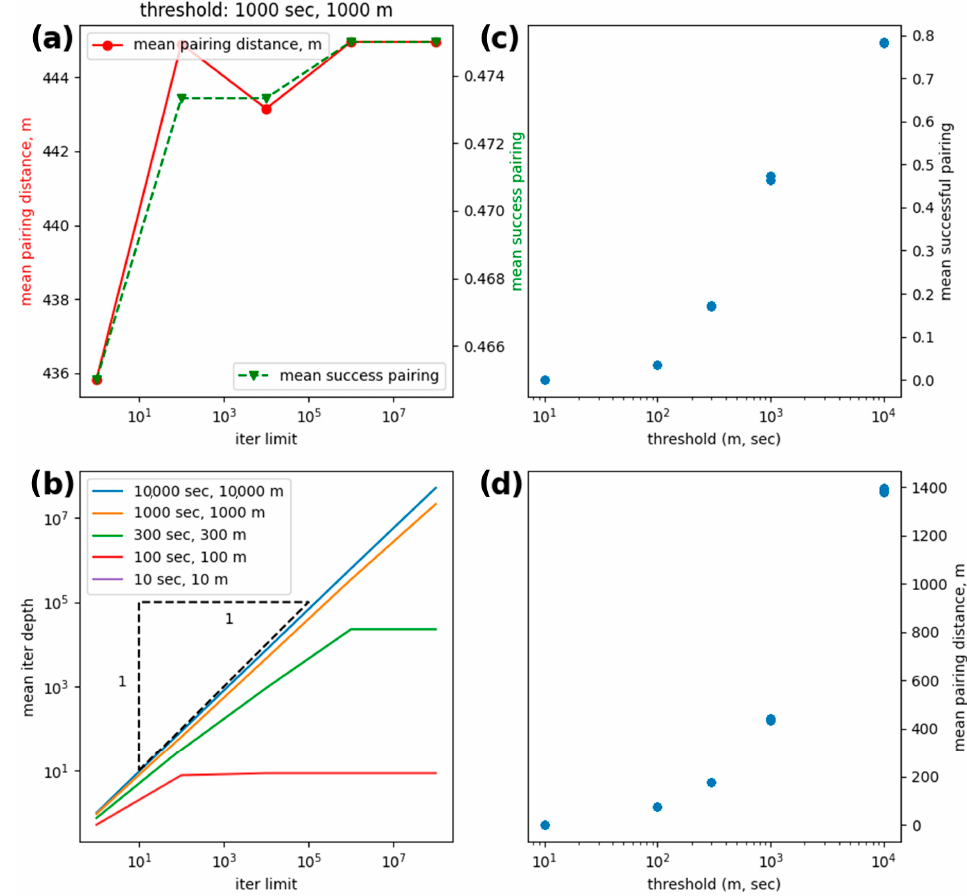
Figure 7. Summary of ship-pairing performance: ( a ) Setting both time and distance thresholds to 1000 s/meters, the dependence of mean pairing distance (left axis) and the mean pairing success (right axis) on the iteration limit: At P max = 10 4 the mean pairing distance drops, while the number of pairings stays constant, and at P max = 10 6 two more pairings are created, which causes the mean pairing distance to increase. ( b ) Dependence of the mean iteration depth on the iter limit for five sets of thresholds, where the saturation occurs at increasingly greater iter limits with increasing thresholds; ( c ) the pairing success rate increases with thresholds; ( d ) mean pairing distance also increases with